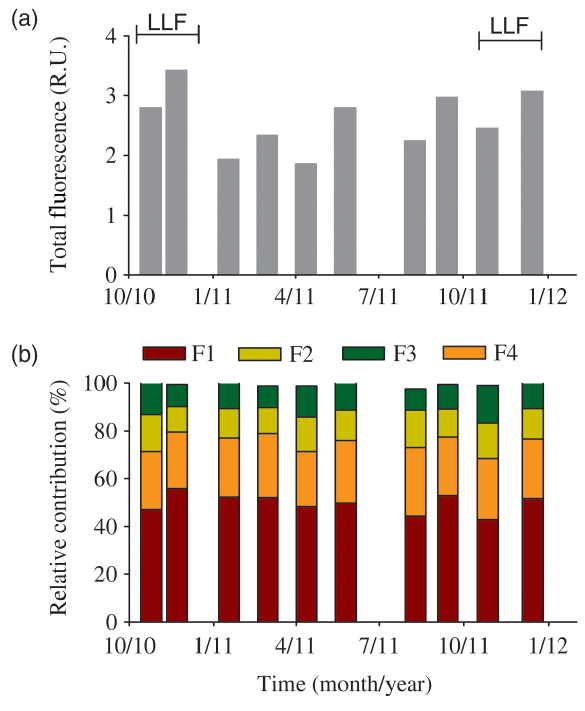
Figure 4. Temporal pattern of (a) total fluorescence of the four PARAFAC components and (b) their relative contribution to total fluorescence in the main stream of the Font del Regàs stream. The fluorescence components F1 and F4 corresponded to protein-like materials, while F2 and F3 corresponded to humic-like materials. Bars are median values for each sampling date. The leaf litter fall (LLF) period is indicated. R.U. are raman units. See more details on the obtained PARAFAC model in Tables S1 and S2 and Fig. S1 (Supplement).